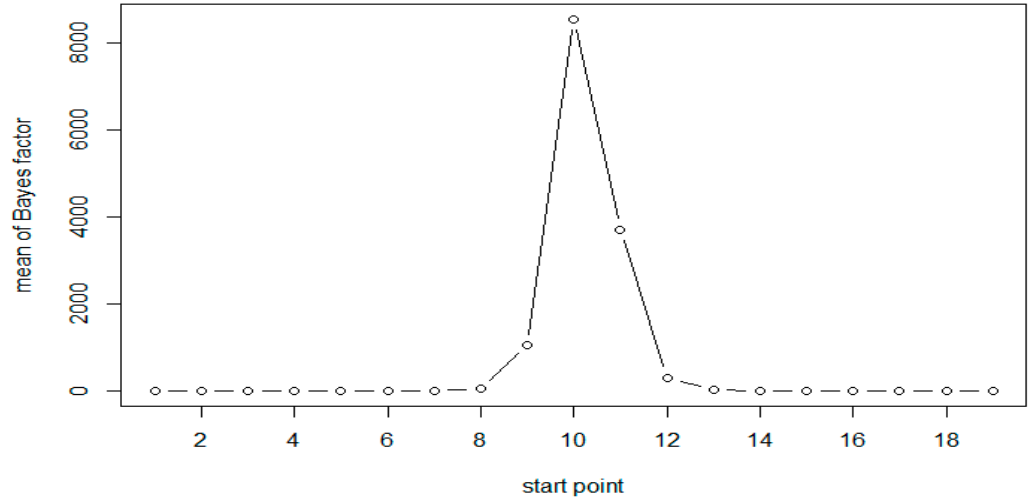
Figure 2. Mean of Bayes factors at each CpG site with N = 100 (Scenario 1). Table 3. Proportions of Bayes factors that fell above the cut-o ff